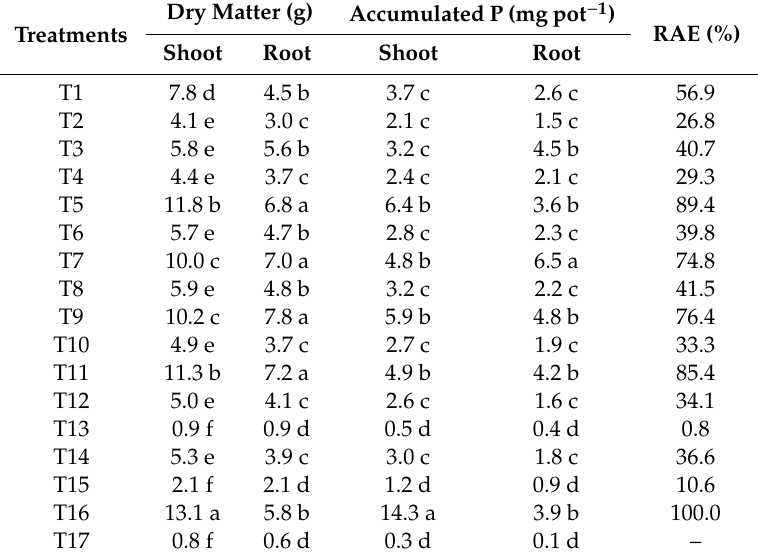
Table 5. Dry matter yield and accumulated P content in shoot and root of maize under phosphate sources partially acidulated with incorporation of pillared clays or